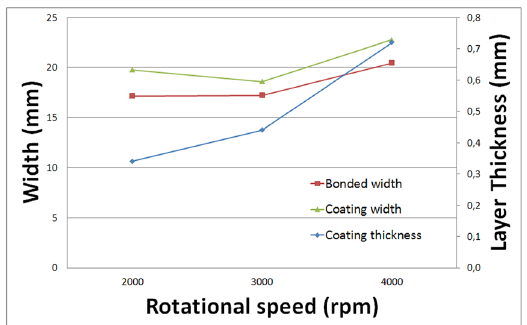
Figure 6. The effects of the rotational speed on the coating thickness and on the bonded and unbonded coating